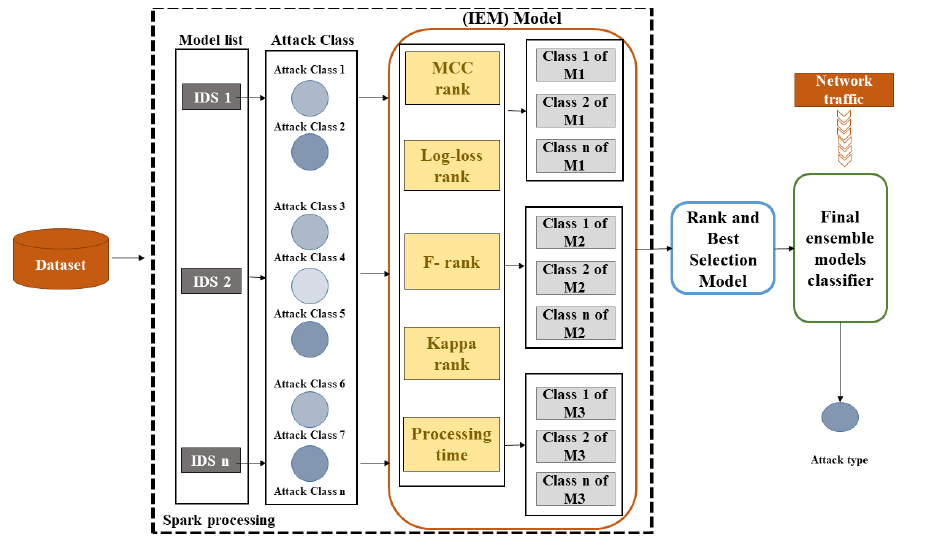
Figure 3. The components of the proposed ensemble detection